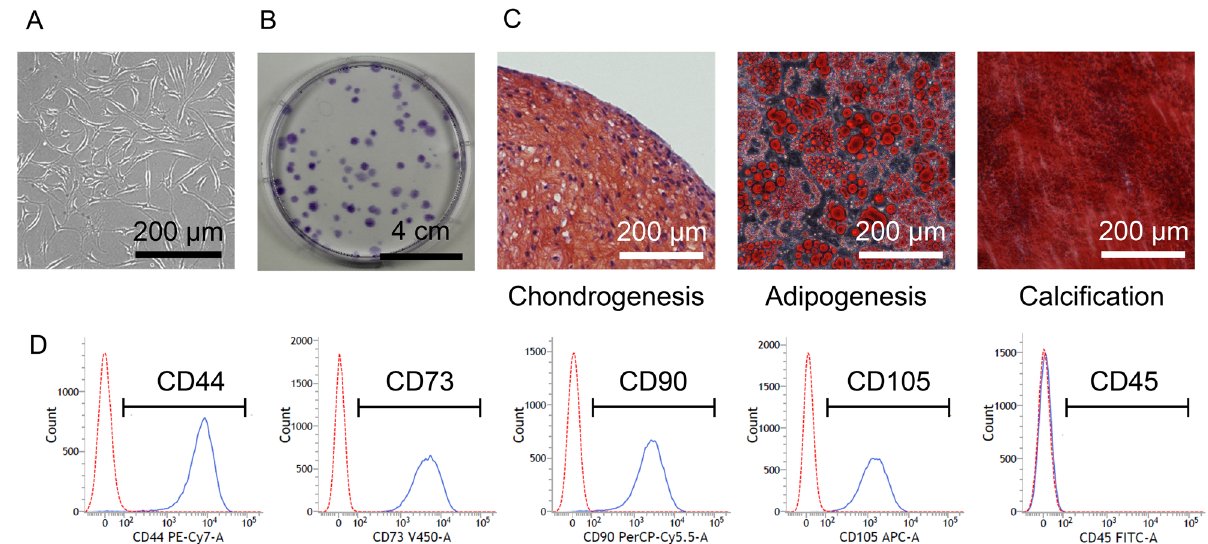
Figure 1. Characteristics of human synovial mesenchymal stem cells. ( A ) Cell morphology. ( B ) Colony formation ability. ( C ) Multidifferentiation ability. ( D ) Surface antigen expression. The indicated surface antigen is shown in blue and the isotype control is shown in